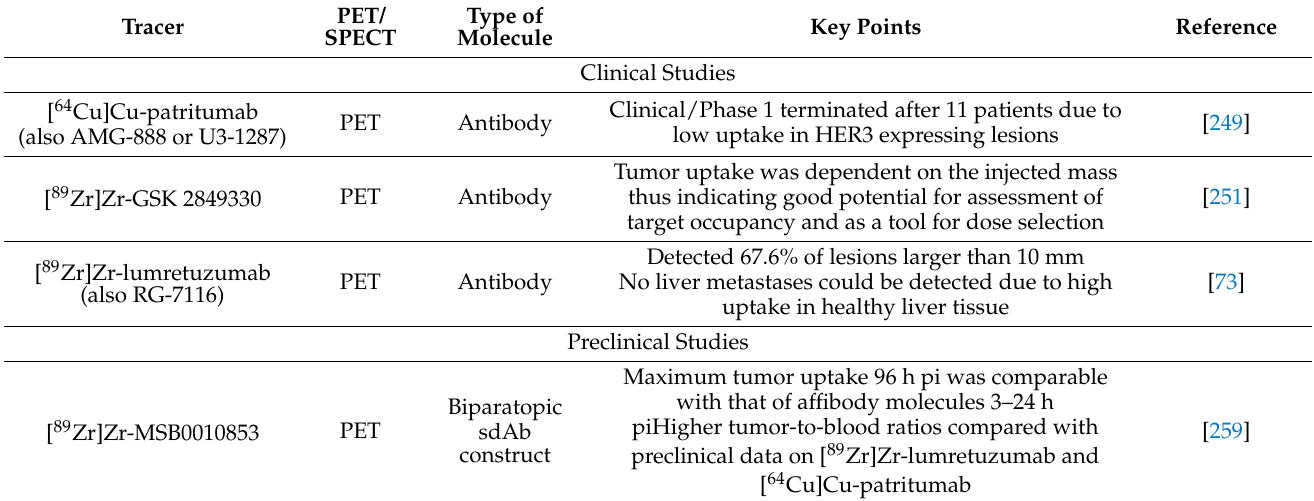
Table 3. Overview of the HER3-targeting imaging agents for PET and SPECT. Tracer Key Points Reference Clinical